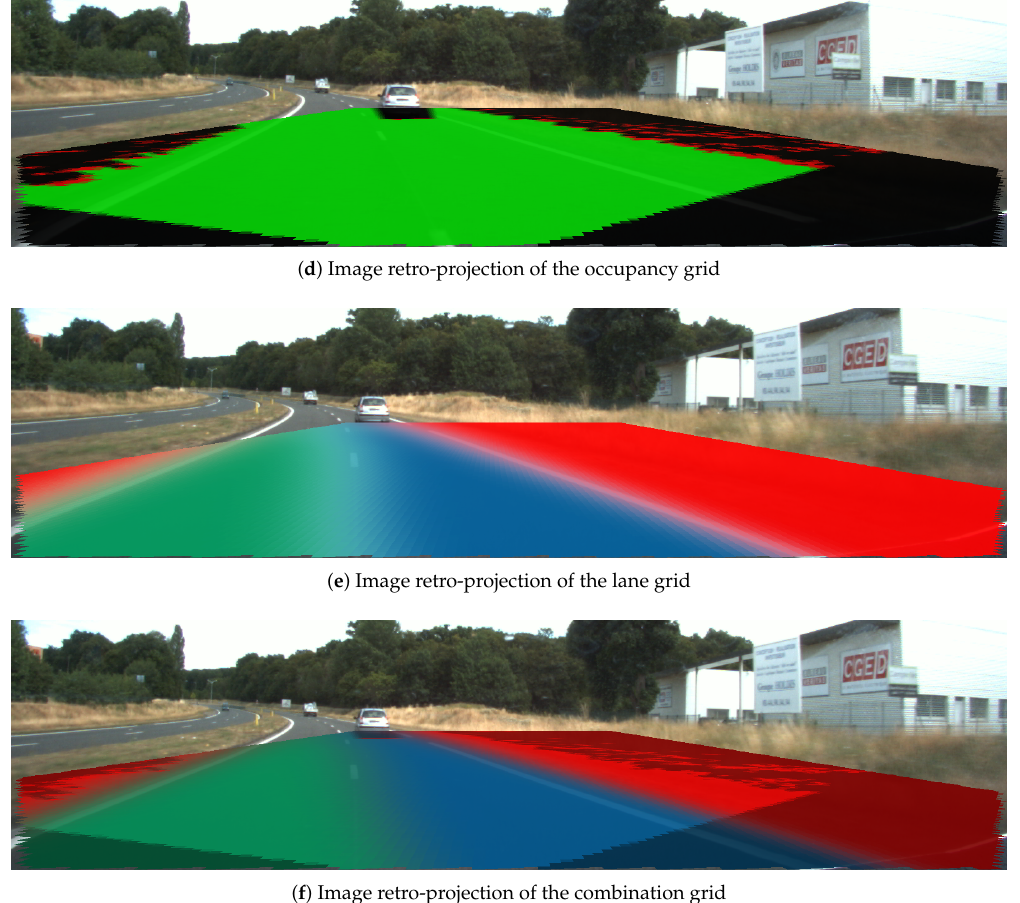
Figure 20. Result scene three when the vehicle is doing a lane change (from left to right). Same color code as in Figure